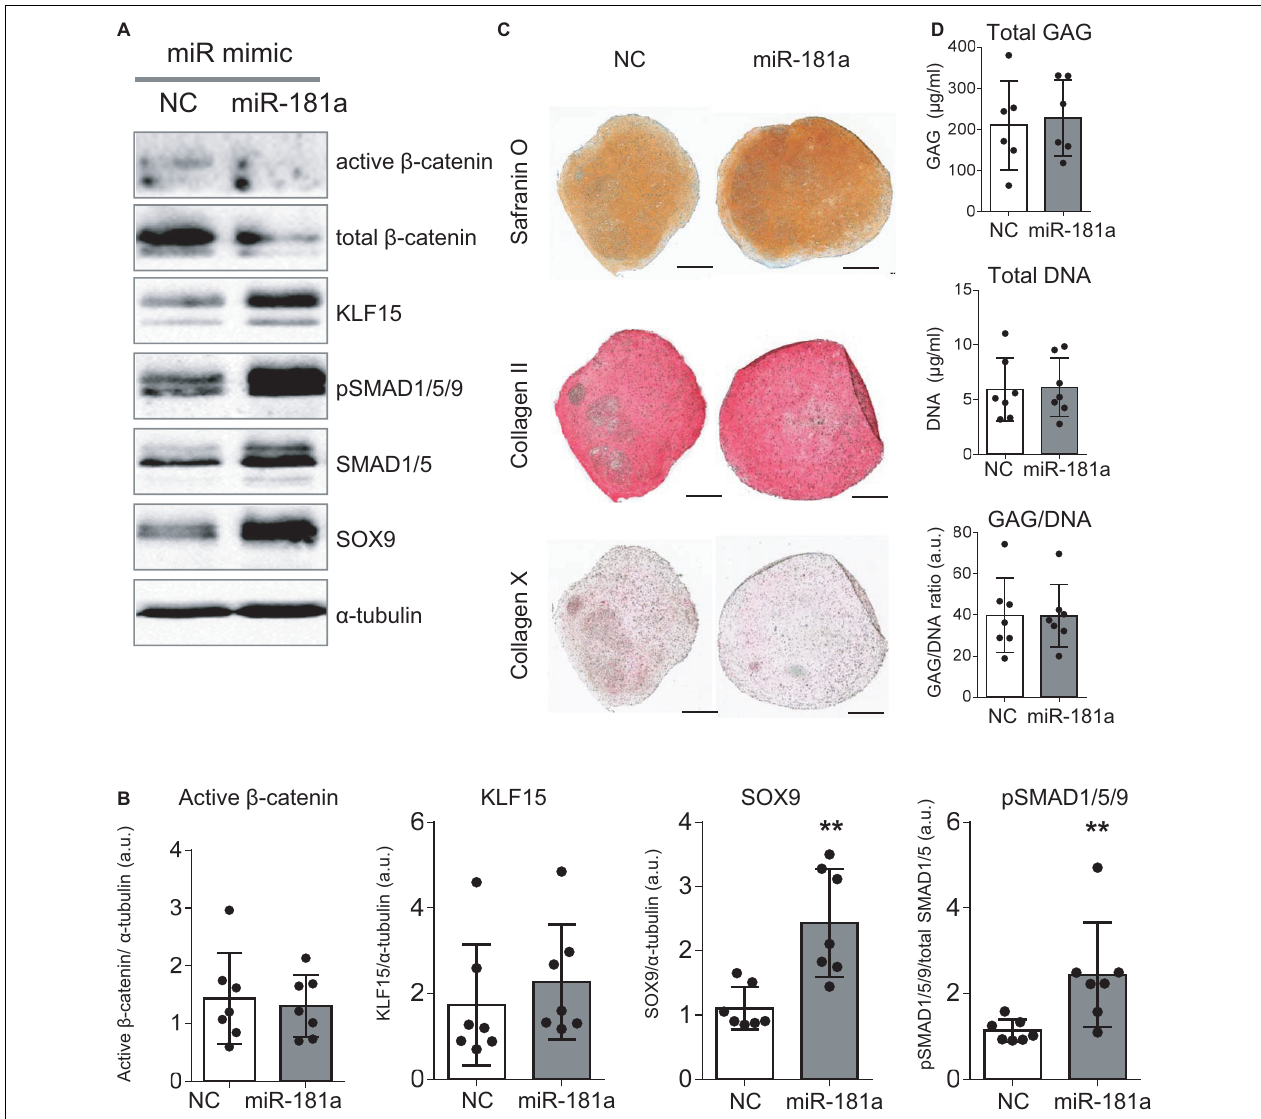
FIGURE 4 | Gain of miR-181a at the start of chondrogenic differentiation boosted MSC chondrogenesis according to enhanced BMP signaling and SOX9 induction. MSC ( N = 5–7) were transfected with miR-181a (gray), or with a control non-targeting miR (NC, white) mimic at day 0, and subjected to chondrogenic differentiation for 28 days. (A) Accumulation of the indicated proteins was assessed by Western blot analysis at day 28; α -tubulin was used as a loading control; (B) Semi-quantitative analysis of WB images; Error bars represent mean values ± SD; N = 7; **p ≤ 0.01 (Mann-Whitney U ); (C) Safranin O staining and immunohistochemistry analysis of COLII and COLX in 3D pellets of the same donor shown in (A) at day 28 of chondrogenesis. Scale bar, 500 µ m. (D) GAG/DNA content of 3D pellet cultures was assessed by DMMB assay at day 28 of chondrogenesis; error bars correspond to mean values ± SD; N = 7